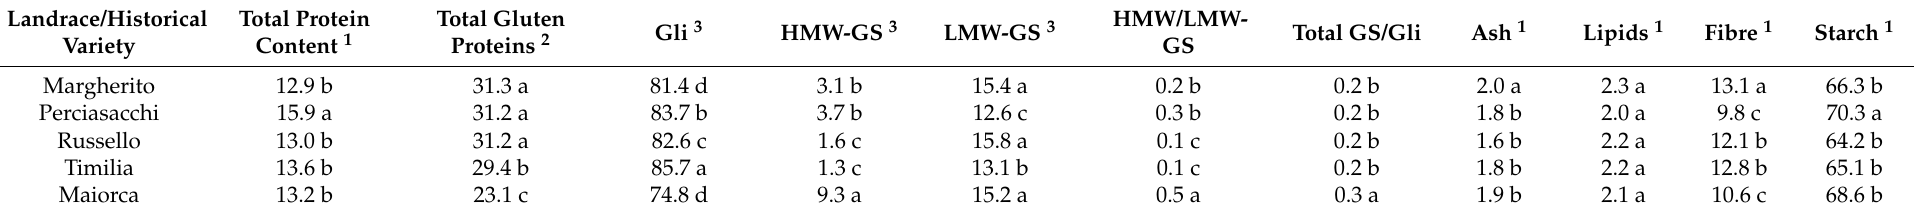
Table 2. Proximate composition and gluten proteins quantification (Gliadins, high molecular weight glutenins—HMW-GS and low molecular weight glutenins -LMW-GS) of Sicilian commercial wheat